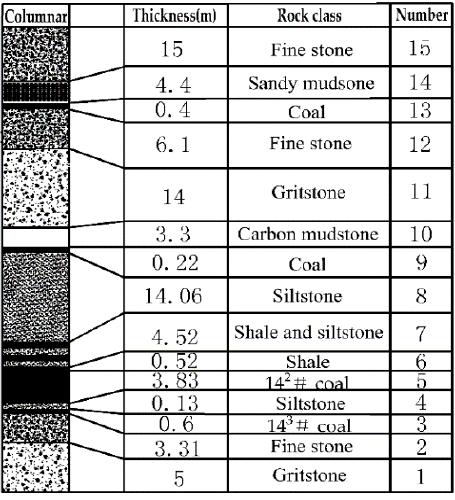
Figure 1. The composite columnar section.